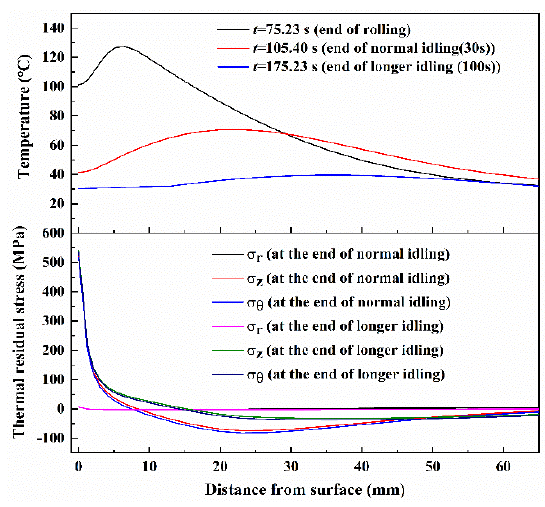
Figure 10. Distribution of the temperature and thermal residual stresses along radial direction at the different instant time points.